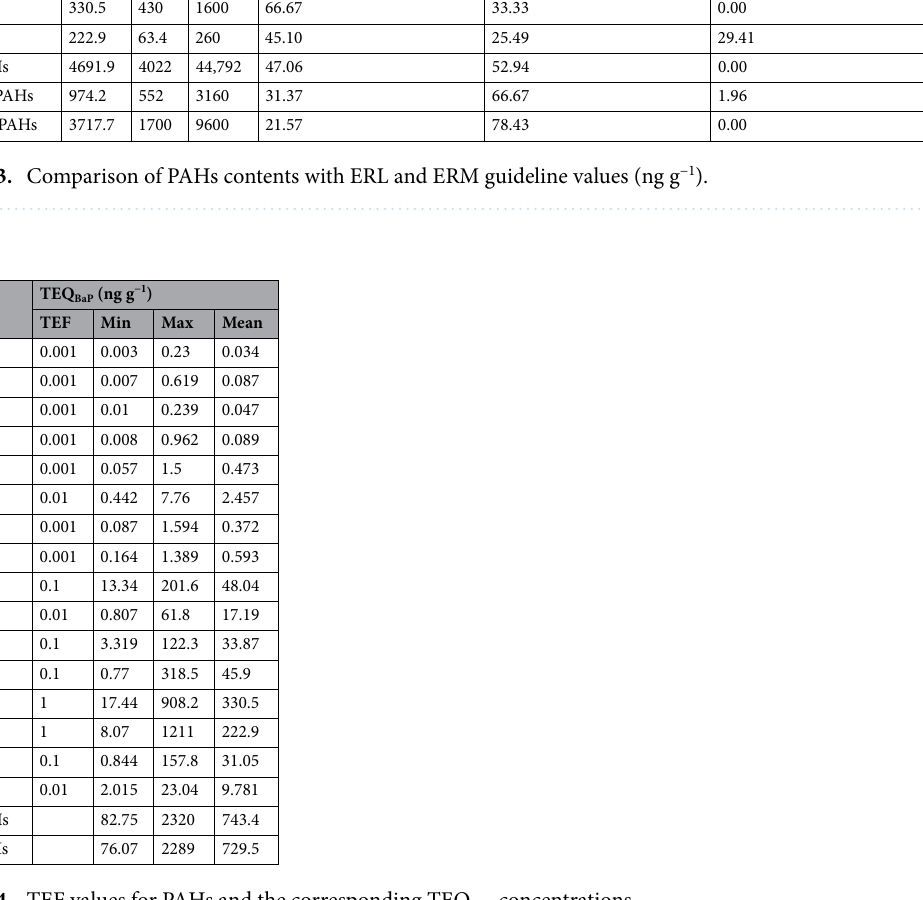
Table 4. TEF values for PAHs and the corresponding TEQ BaP